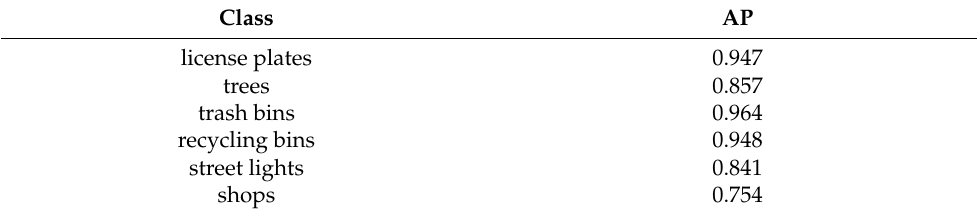
Table 2. Average precision of each object class at 0.7 IoU